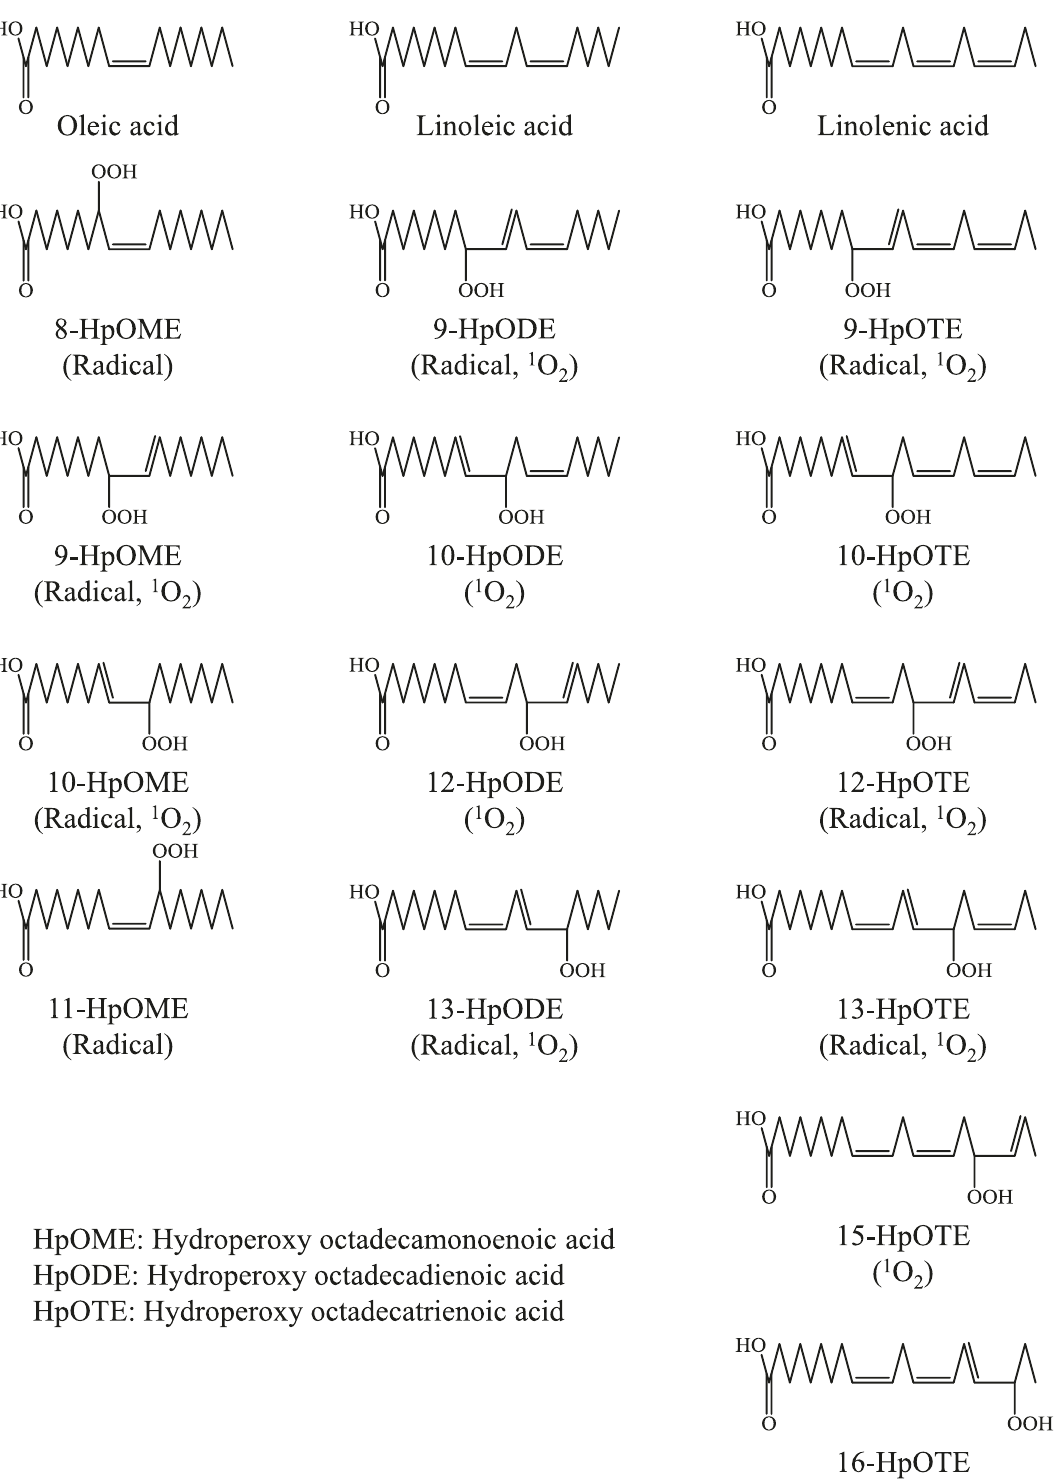
Fig. 1 Chemical structures of OA, LA, LnA, and their hydroperoxyl group positional isomers. Each isomer is generated by radical and/or 1 O 2